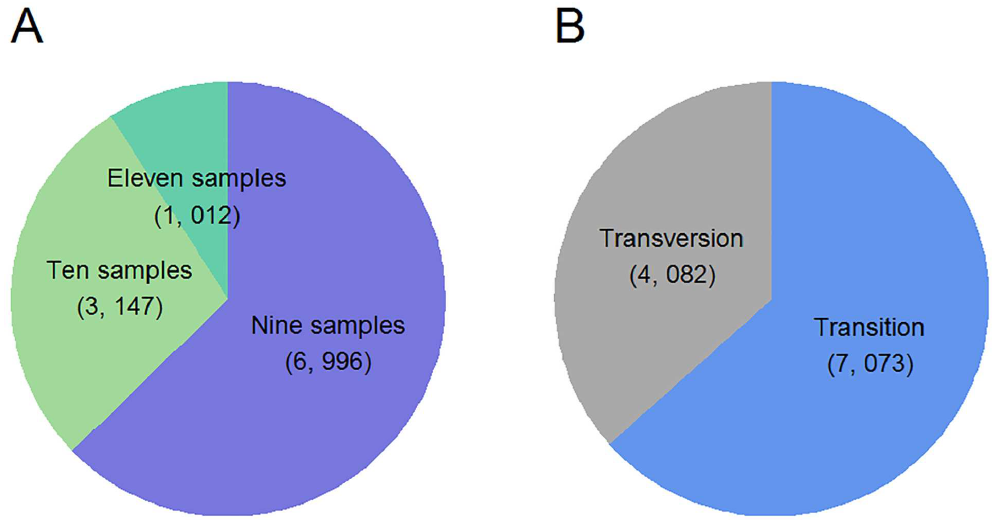
Fig 2. Proportions of all detected SNPs simultaneously observed among different numbers of samples (A) and the ratio of transition to transversion events(B).